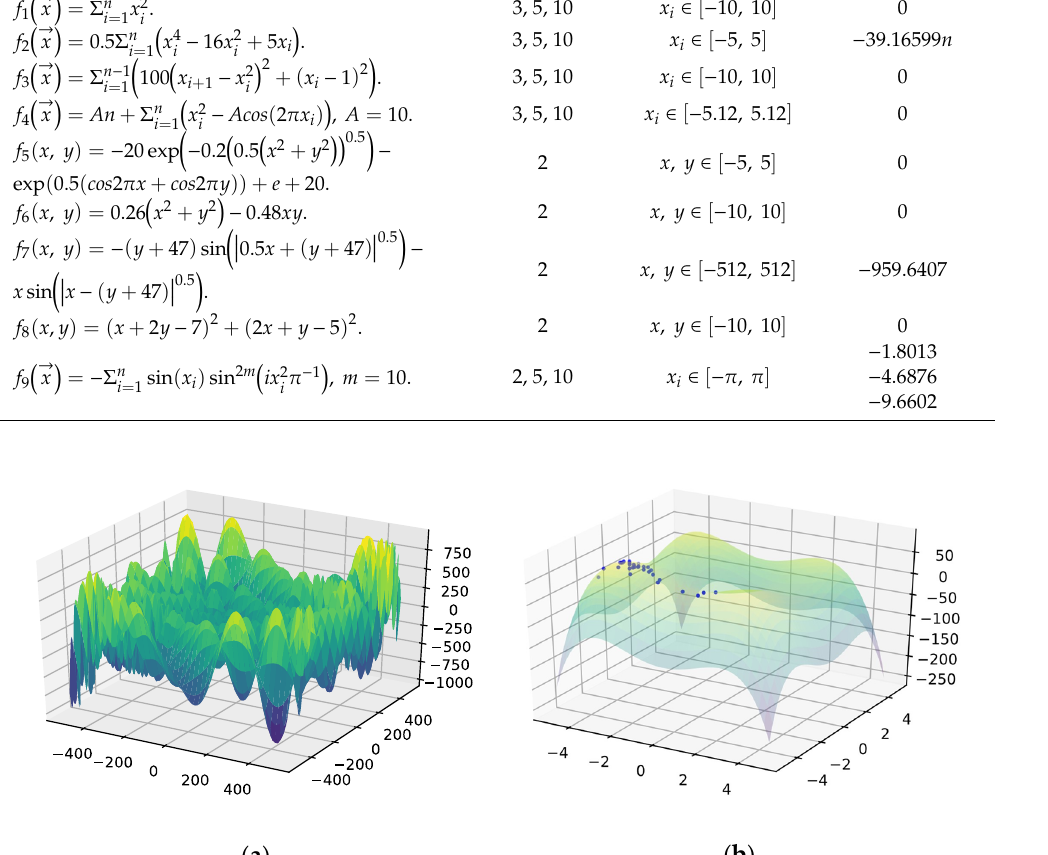
Table 2. Accuracy comparison of the algorithms optimizing 5-dimensional functions from Table 1.